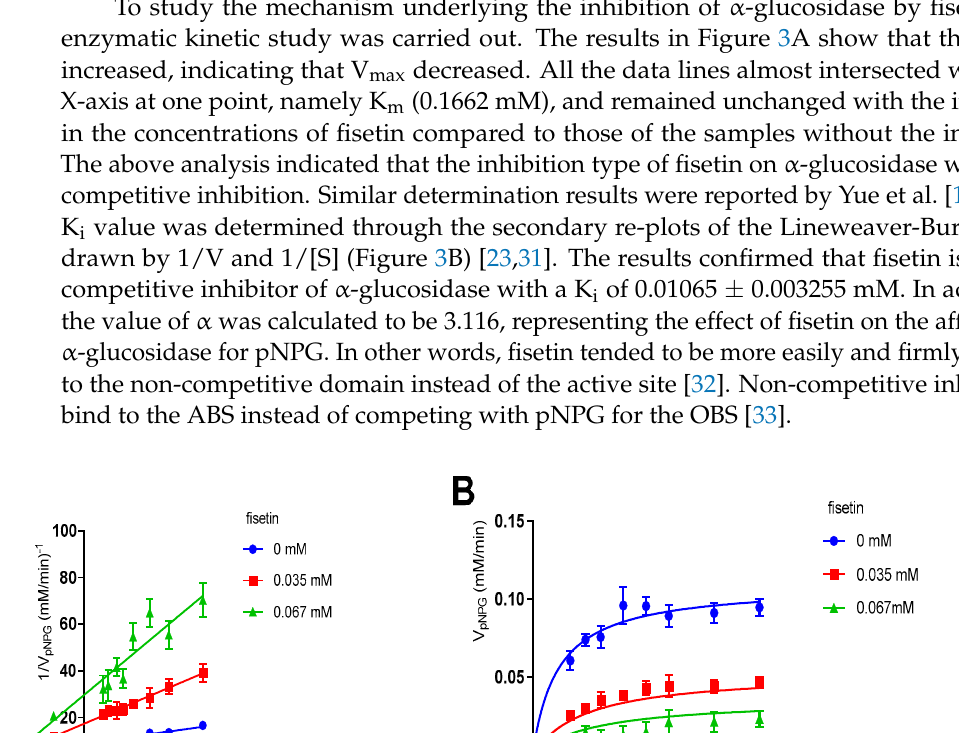
Figure 2. α‐ glucosidase inhibitor assay. ( A ) Inhibitory activity of fisetin against α‐ glucosidase. ( B ) Inhibitory activity of acarbose against α‐ glucosidase.